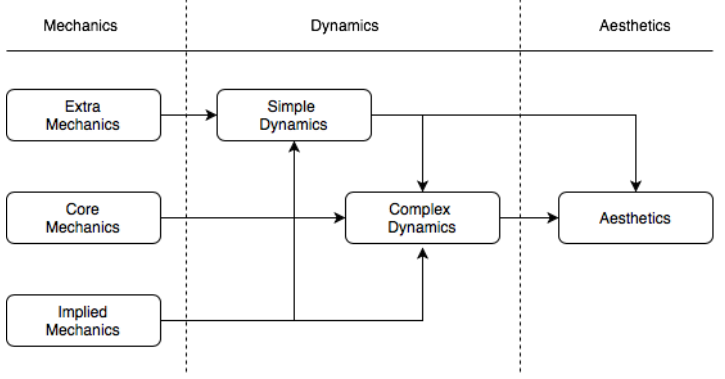
Figure 2. Diagram of the RMDA